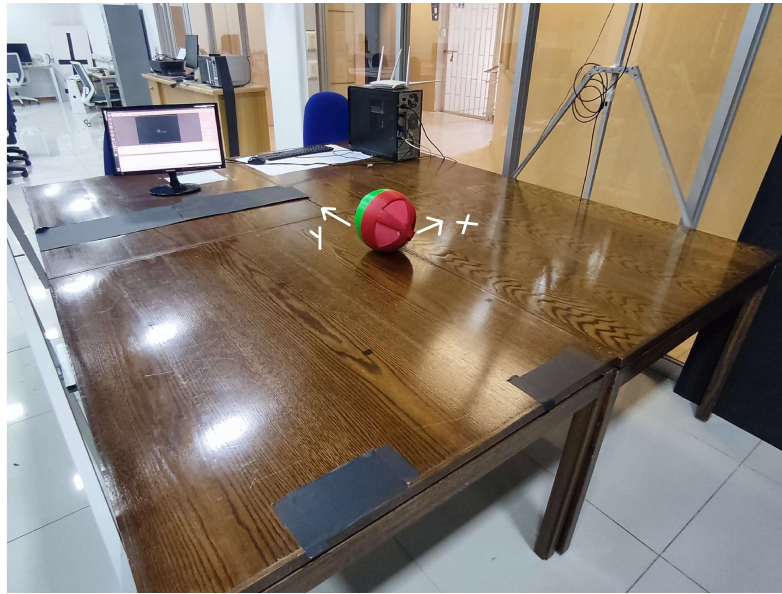
Figure 4. Test platform for the spherical robot.